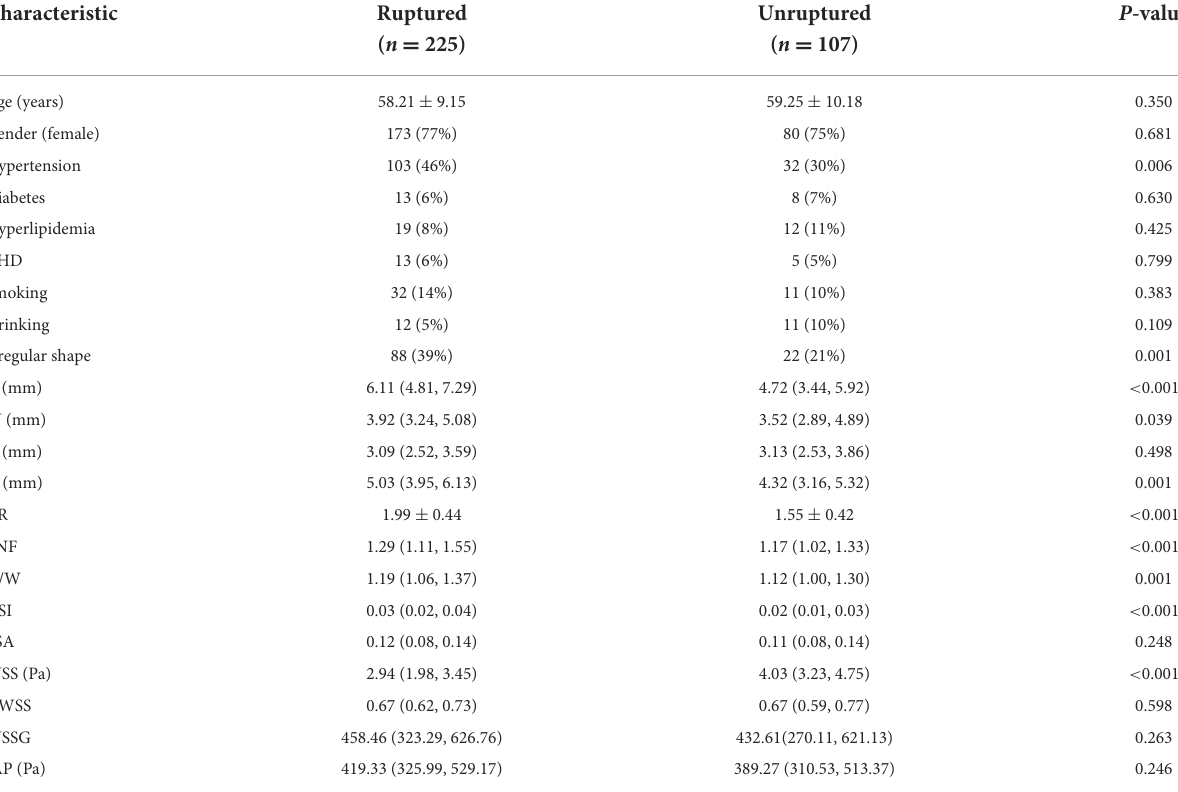
TABLE 2 The clinical, morphological, and hemodynamic characteristics between ruptured and unruptured groups in the training cohort.